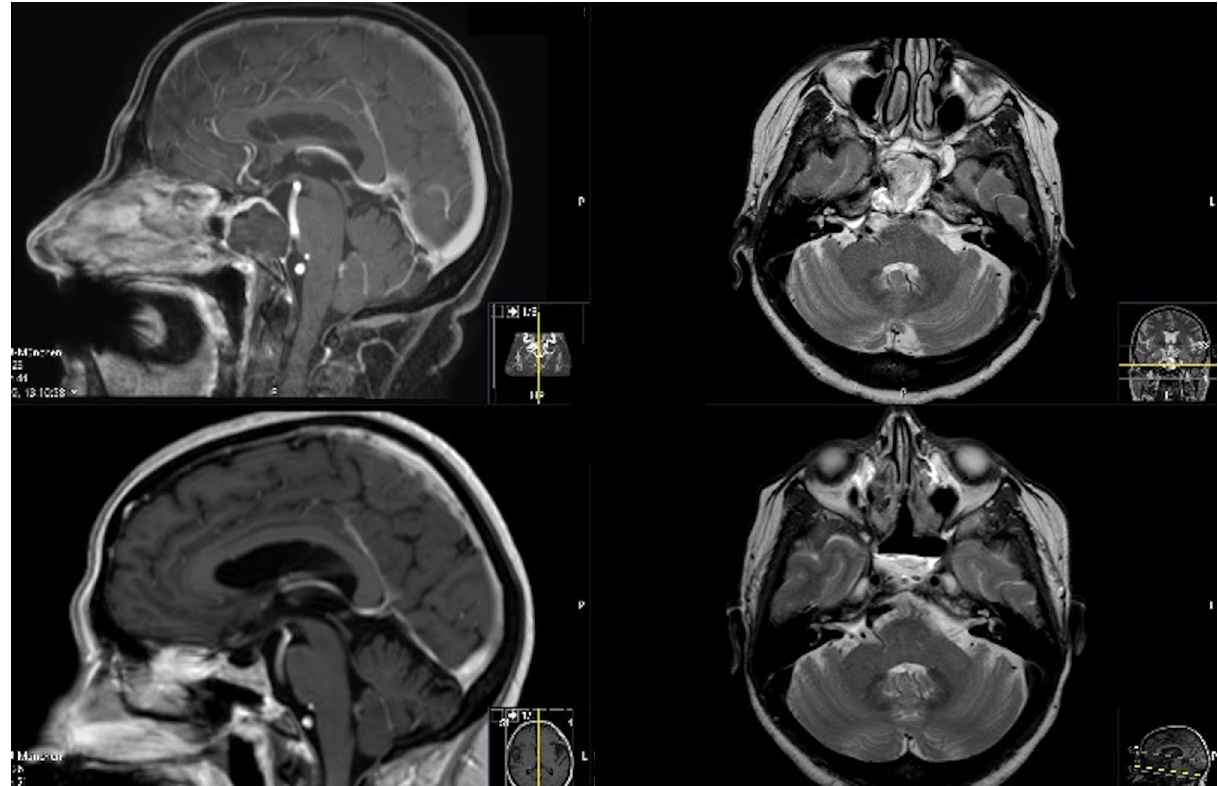
Figure 3. Preoperative T1 with contrast enhancement and T2-weighted MRI scan of a 60-year-old female patient suffering from a clival chordoma (upper images), with postoperative MRI revealing a gross total tumor resection after the transnasal